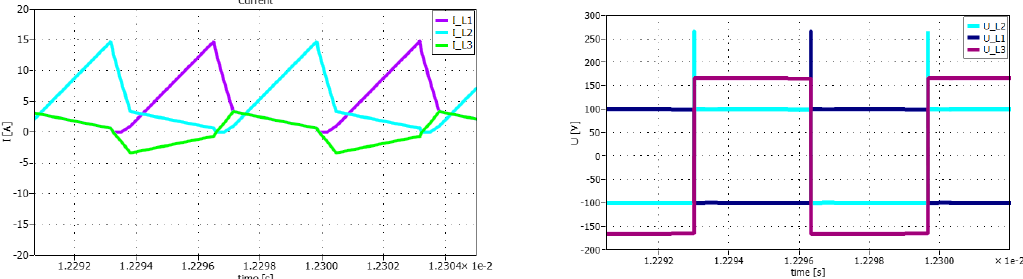
Figure 9. Time waveforms received from the simulation experiments of the MPPT converter. ( left ) Waveforms of the inductor’s currents; ( right ) Waveforms of the inductor’s voltages.